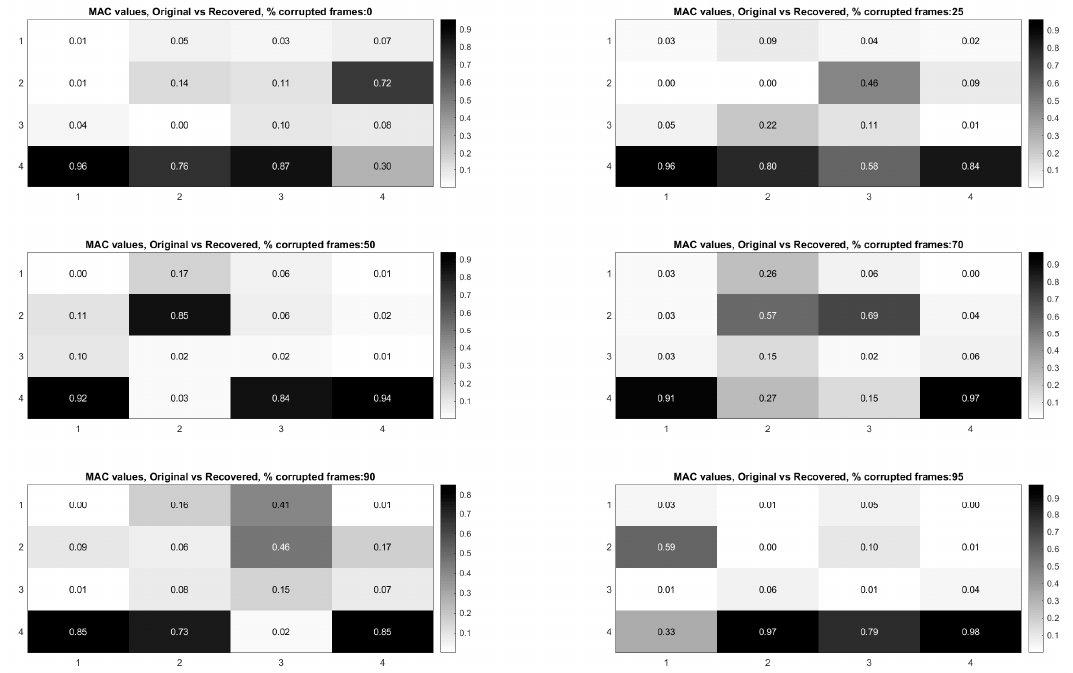
Figure 24. Modal assurance criterion values for the vibrating cantilever beam videos with randomly shuffled frame order and frames randomly removed.